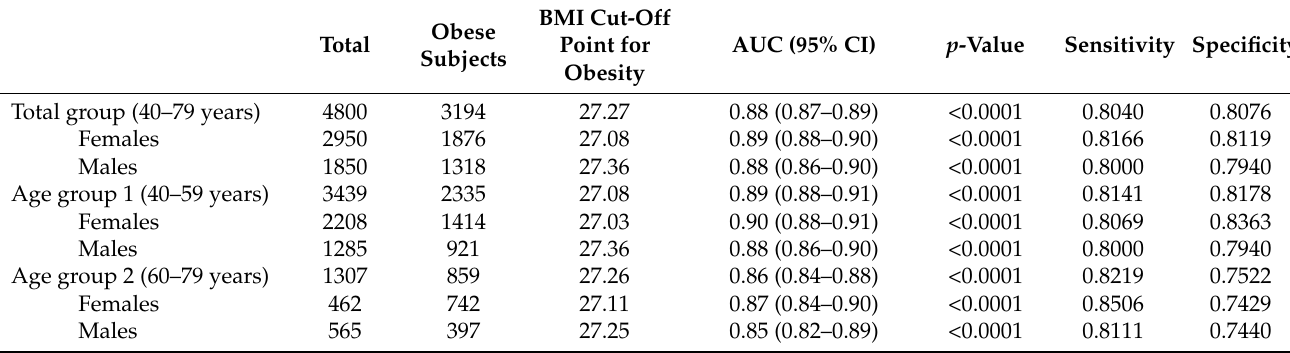
Table 2. Diagnostic performance of the new BMI cut-off points for obesity by age and gender and overall sample ( n = 4800).